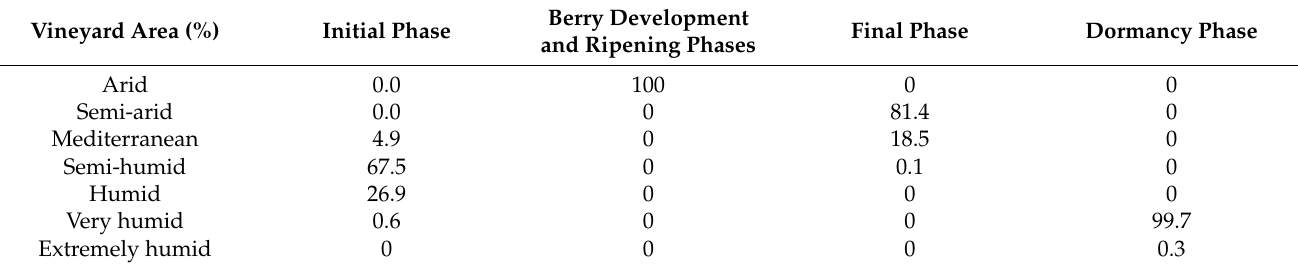
Table 6. Spatial classification in vineyard areas of the Ribera del Guadiana Protected Denomination of Origin (%) according to the I DM for the vine phases